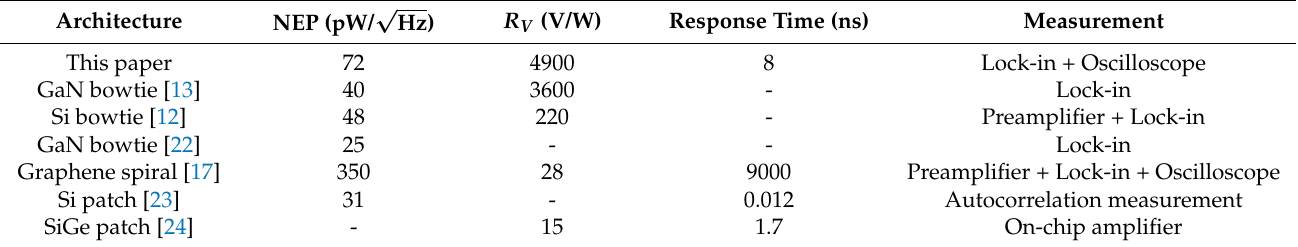
Figure 5. ( a ) Measured V DS versus V GS and V lock curves of the three samples with different I L . ( b ) Simulated normalized V DS as a function of the V GS at different leakage currents. ( c ) Responsivity and NEP versus V GS of sample 1. ( d ) Measured and fitted V lock versus amplitude modulation frequency of electromagnetic wave of sample 1. ( e ) Temporal response of the fabricated device chopped by an electronic modulator at 1 kHz of sample 1. ( f ) Measured response time of sample 1. Table 1. Comparison of the performance and efficiency of the proposed and previously reported detectors at room